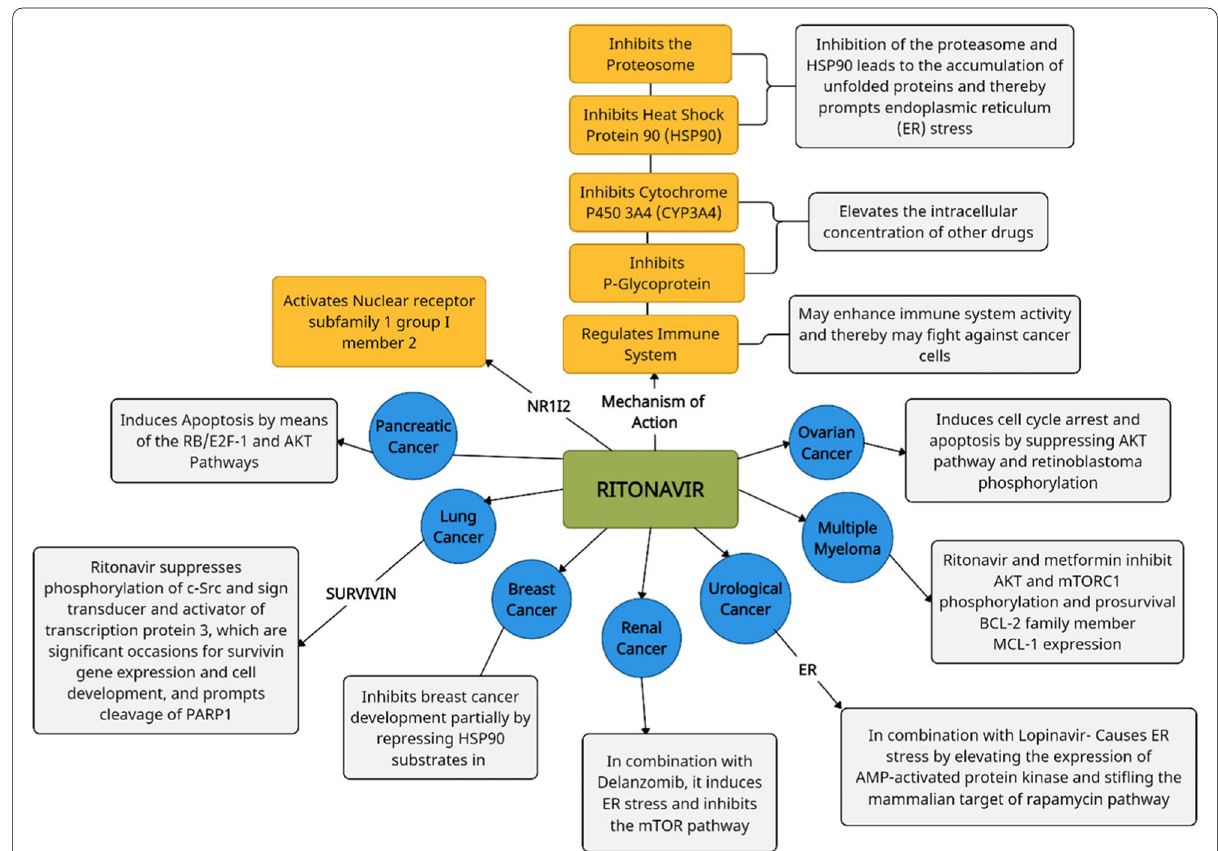
Fig. 3 Pictorial representation of diverge mechanisms of action of ritonavir in different cancers. Ritonavir is thought to apply its anti-cancer action by hindering numerous signaling pathways, including the AKT and nuclear factor-kappa B pathways; it also inhibits survivin, HSP90 substrates and induces ER stress and apoptosis by blocking Akt pathways in various